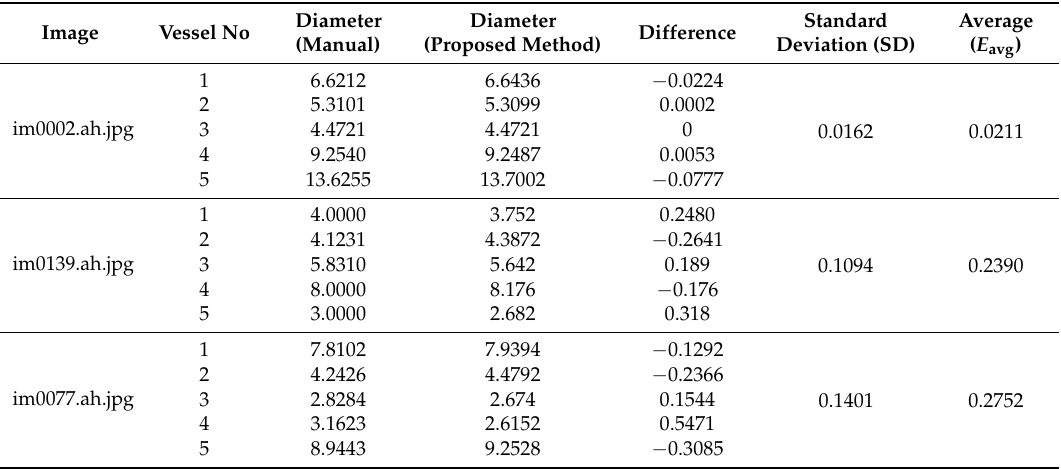
Table 1. Comparison of the diameter measurements (in pixels) between the proposed method and manual method for the STARE Database.